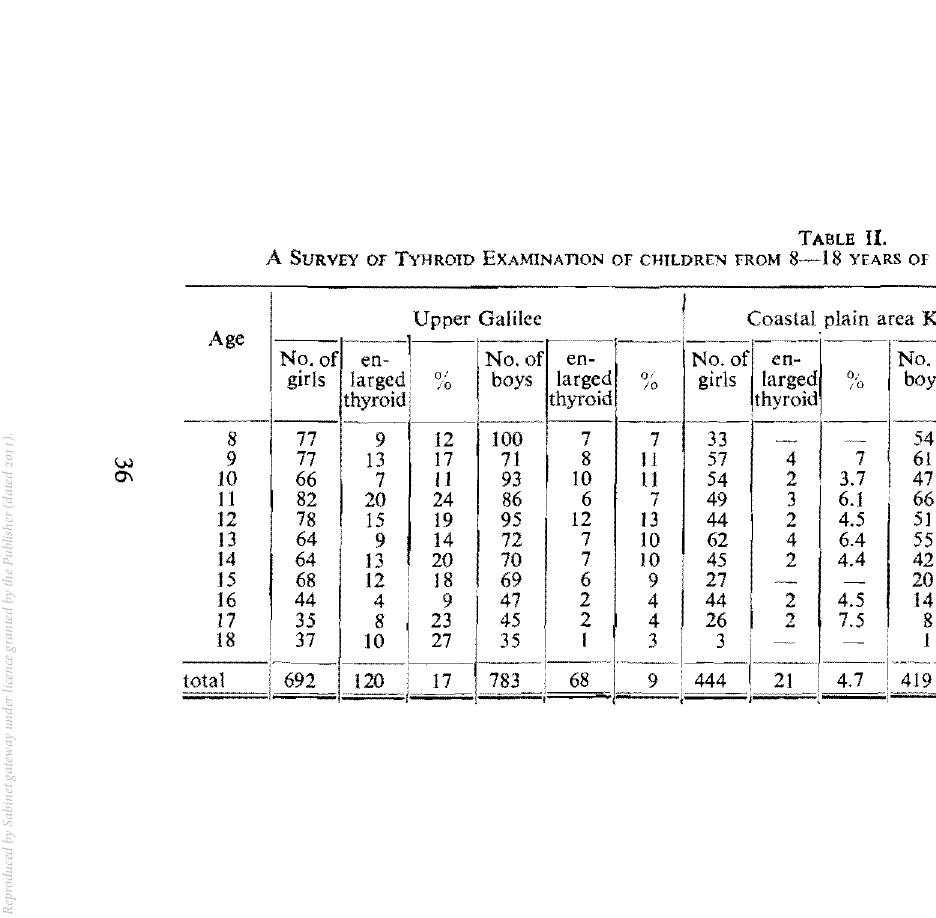
A SURVEY OF TYHROID EXAMINAnON OF CHILDREN FROM 8-18 YEARS OF AGE IN UPPER GALILEE AND COASTAL PLAIN AREA-ISRAEL. Upper Galilee Coastal plain area K. Motzkin Coastal plain area K. Bialik.